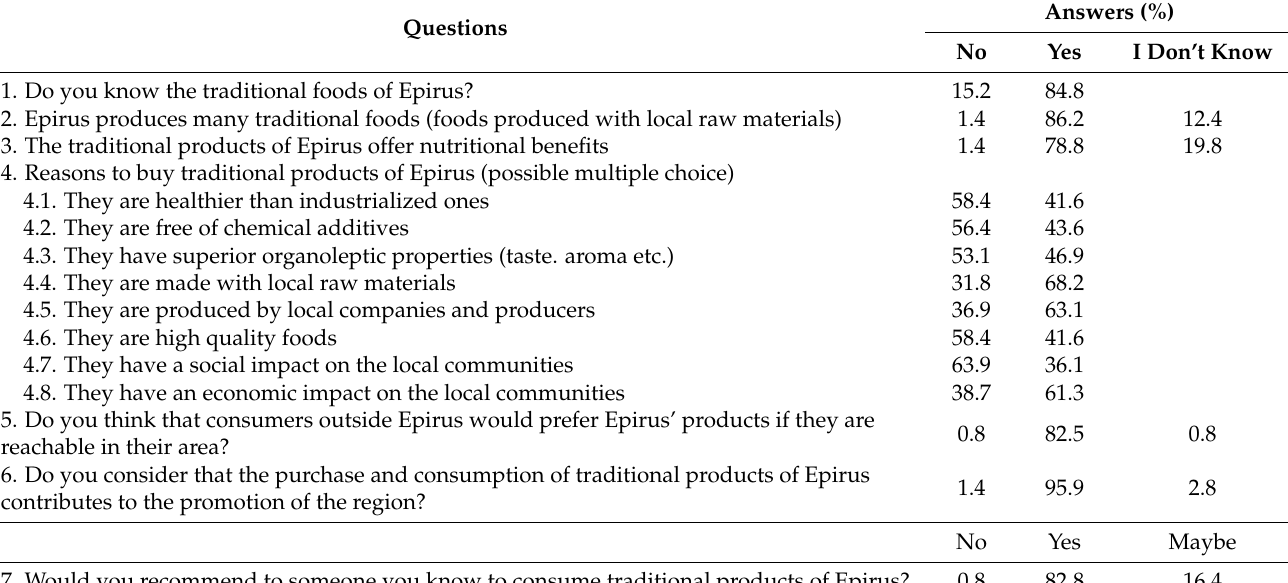
Table 4. Participants’ perception of the TFs of Epirus.